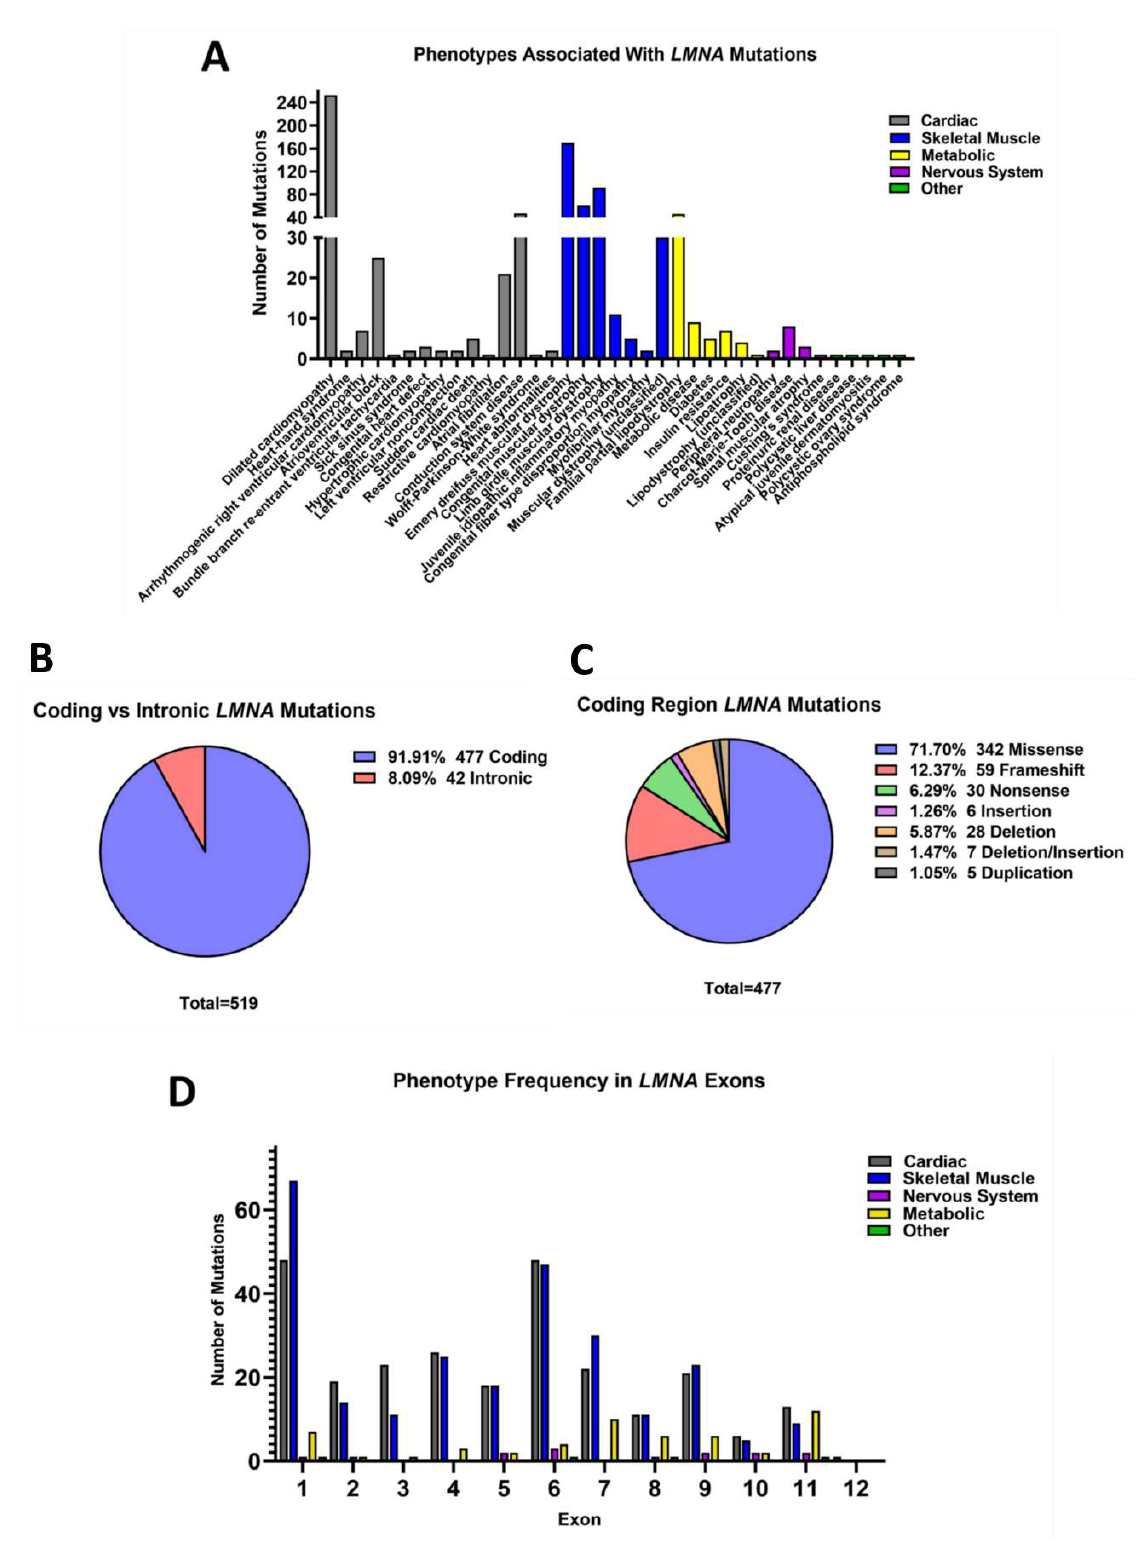
Figure 3. LMNA mutations. ( A ) Phenotypes associated with LMNA mutations. There were 37 dif- ferent conditions that were found to be associated with LMNA mutations, some which were caused by identical LMNA variants. These can be broadly classified into diseases affecting cardiac muscle, skeletal muscle, the metabolic system and the nervous system. A few variants caused diseases that fell into other categories. ( B ) Coding vs. intronic mutations. A total of 519 LMNA mutations were identified. 477 (91.91%) were coding mu- tations, whilst 42 (8.09%) were splice-site variants. ( C ) Coding region mutations. Missense